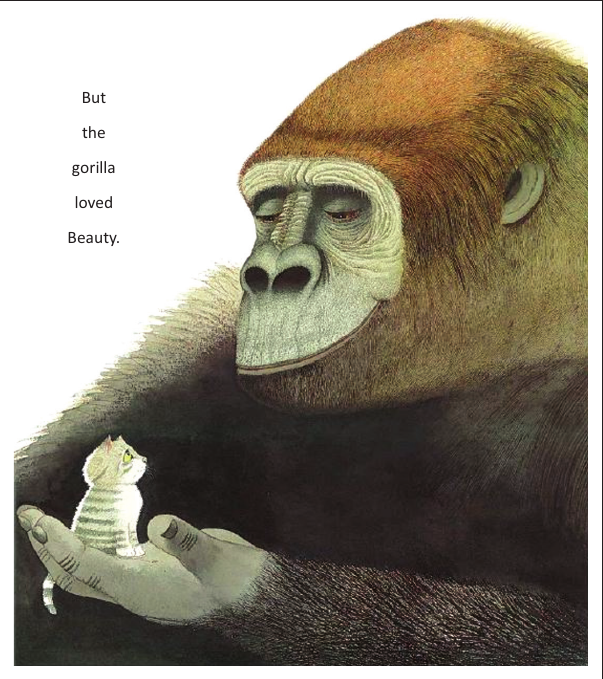
FIGURE 2: But the gorilla loved